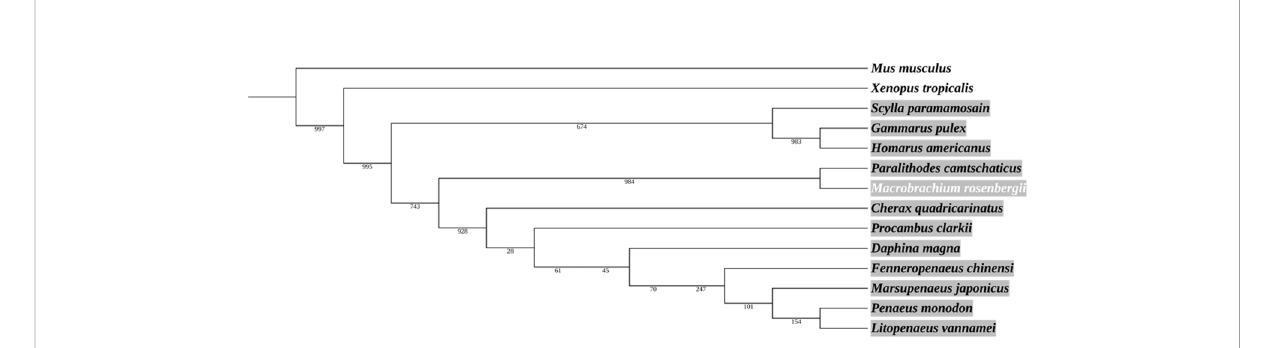
FIGURE 2 Phylogenetic analysis of Ras protein in crustaceans, including M. rosenbergii. The area marked in grey represents the crustaceans. The neighbor-joining tree was constructed according to the alignment of the entire Ras amino acid sequence. The numbers alongside the branches represent bootstrap values. The rodent Mus musculus and the amphibian Xenopus tropicalis served as